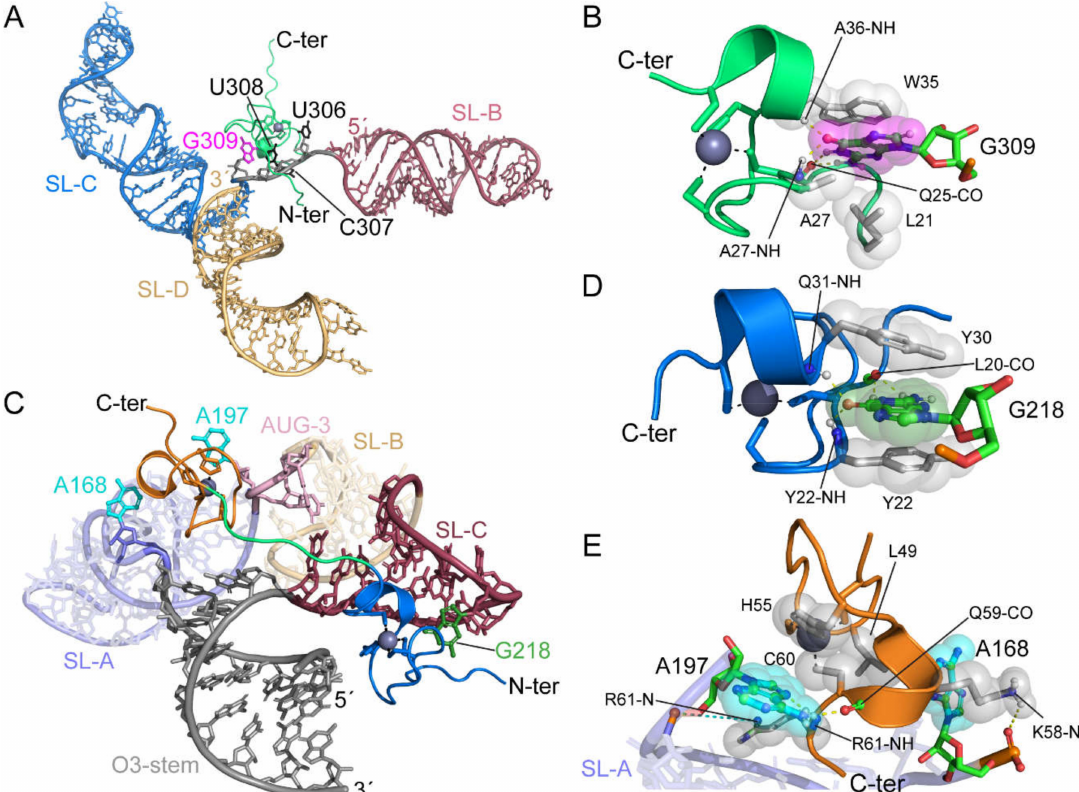
Figure 16. Complex structures of MoMuLV and RSV NC bound to the recognition elements in their respective packaging signals (reported in [71] and [117], respectively). ( A ) MoMuLV NC-UCUG complex structure (PDB ID: 1U6P). SL-B, SL-C, and SL-D are colored in red, blue, and gold, respectively. The UCUG linker and binding site is colored gray with G309 in magenta. The zinc knuckle domain of the MoMuLV NC is shown in green, with the black dashes representing the coordination of Zn. ( B ) The direct interaction between the MoMuLV NC and G309. Hydrogen bonds are shown as yellow dashes and the gray spheres represent hydrophobic interactions. ( C ) RSV NC bound to the µ Ψ packaging signal (PDB ID: 2IHX). The O3-stem, SL-A, AUG-3 linker, SL-B, and SL-C are colored gray, purple, pink, gold, and red, respectively. The N-terminal zinc knuckle, linker residues, and C-terminal zinc knuckle are colored blue, green, and orange, respectively. G218 nucleobase is colored green. A168 and A197 nucleobases are colored cyan. ( D ) The N-terminal zinc knuckle of the RSV NC interacting with G218. ( E ) The C-terminal zinc knuckle interacting with A168 and A197. Salt bridge interactions are depicted as cyan-colored